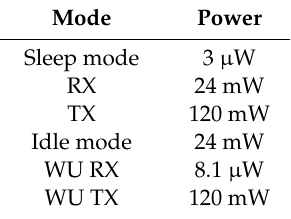
Table 1. Energy consumption values corresponding with the modem described in [15].